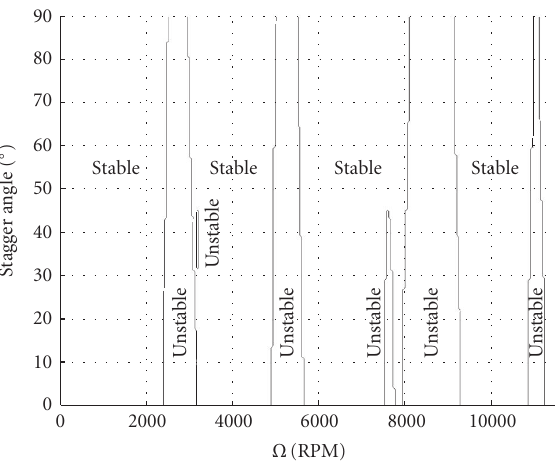
Figure 15: Stability map of a two-flexible-bladed rotor as a function of its stagger angle and its rotational speed.